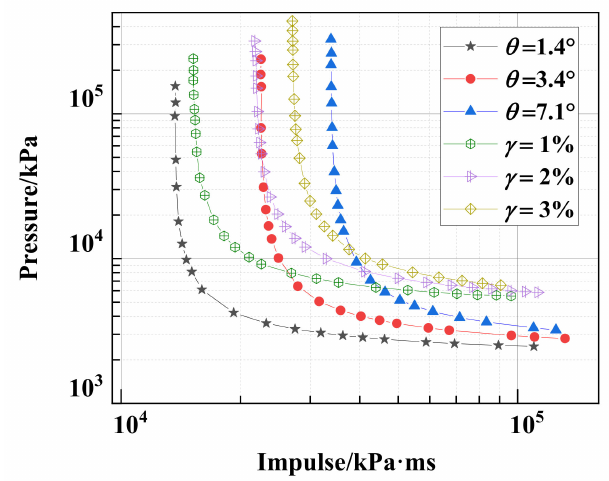
Figure 9. Bending-shear response P-I curves.